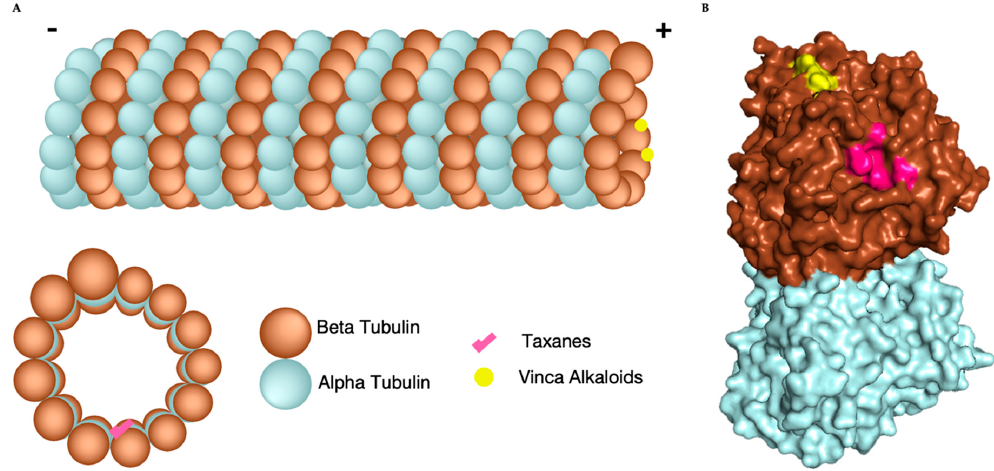
Figure 1. Microtubule composition, structure, and microtubule targeting agents (MTA) binding sites. ( A ) Cartoon of microtubule consisting of 13 protofilaments formed from alpha (blue) and beta (brown) tubulin heterodimers. Vinca alkaloids (yellow) bind to the + end of the microtubule and taxanes (pink) bind inside the lumen (lower left). ( B ) Space Filling model an of alpha (Blue) beta (Brown) heterodimer with vinca alkaloid binding site (yellow) and taxane binding site (pink) located on beta tubulin [PDB: 3J8Y].